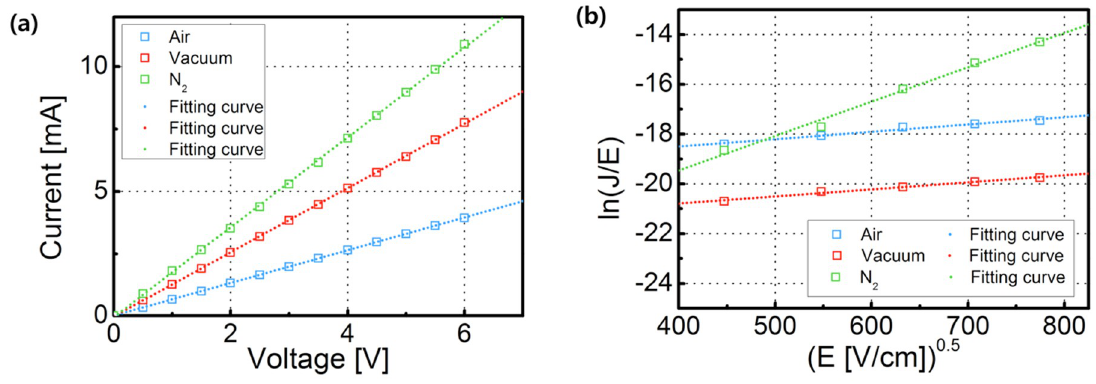
Figure 5. ( a ) Ohmic transport mechanism of LRS and ( b ) Poole–Frenkel transport mechanism of